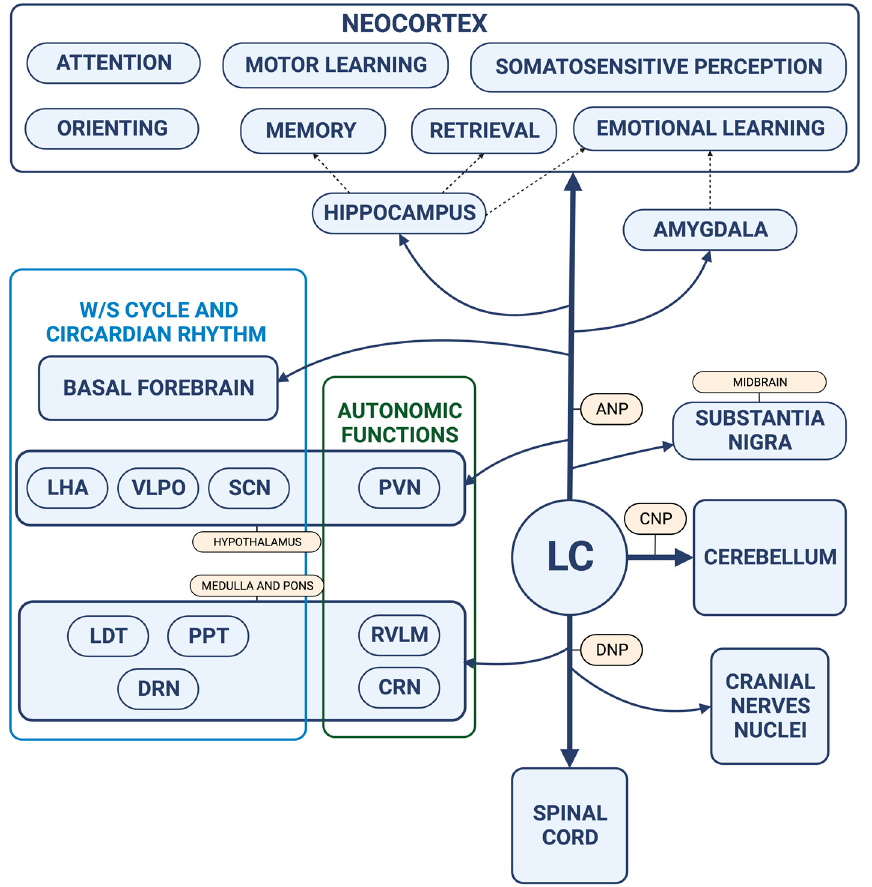
Figure 2. The LC provides a dense and widespread system of projections that virtually reaches the whole CNS. From the anatomical nucleus, NA fibers travels segmented into three pathways: an ascending pathway (ANP) through which the LC reaches the midbrain and the forebrain, a cerebellar pathway (CNP), and a descending pathway (DNP), which carries the NA fibers for the lower pons, the medulla, and the spinal cord. Through such anatomical connections, the LC enters the circuitries of the sleep/wake cycle and circadian rhythms regulatory nuclei and of autonomic system modulatory nuclei. Rostrally, the LC reaches the limbic system and the neocortex, taking part in the complex orchestration of cognitive and behavioral functions, such as attention and memory. (Created with Biorender.com, accessed on 15 March 2023). Abbreviations: ANP: Ascending Noradrenergic Pathway; CNP: cerebellar noradrenergic pathway; CNS: central nervous system; CRN: caudal raphe nuclei; DNP: descendent noradrenergic pathway; DRN: dorsal raphe nucleus; LC: locus coeruleus; LDT: lateral dorsal tegmental nucleus; LHA: lateral hypothalamic area; NA: noradrenaline; PPT: pedunculo-pontine tegmental nucleus; PVN: paraventricular nucleus; RVLM: rostral ventro-lateral medulla; SCN: suprachiasmatic nucleus; VLPO: ventro-lateral preoptic area; W/S: wake and sleep cycle.